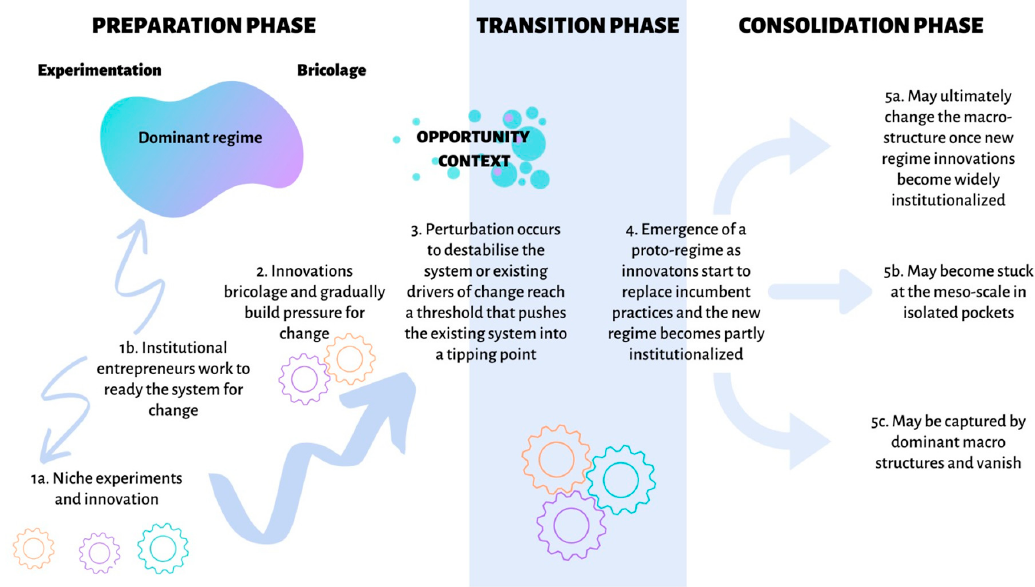
Figure 2. Three phases whereby innovations can cause a system to undergo a regime shift, or transform from one system state to another. The preparation phase requires innovations and experiments to be developed and over time to bricolage, whilst institutional entrepreneurs ready the system for change by bridging between the niche and the regime. A window of opportunity opens up when a perturbation weakens the incumbent system and this allows the innovations that have previously been marginal to become partly institutionalized during the transition phase. The third phase involves three pathways; a- where the resilience of the new regime is built and it becomes the new status quo; b- where the proto-regime becomes stuck and is isolated in pockets; c- where the dominant regime is so resilient that it adapts to the shock and reconfigures itself by capturing the innovations so that they do not result in transformative change. (Adapted from [65]).